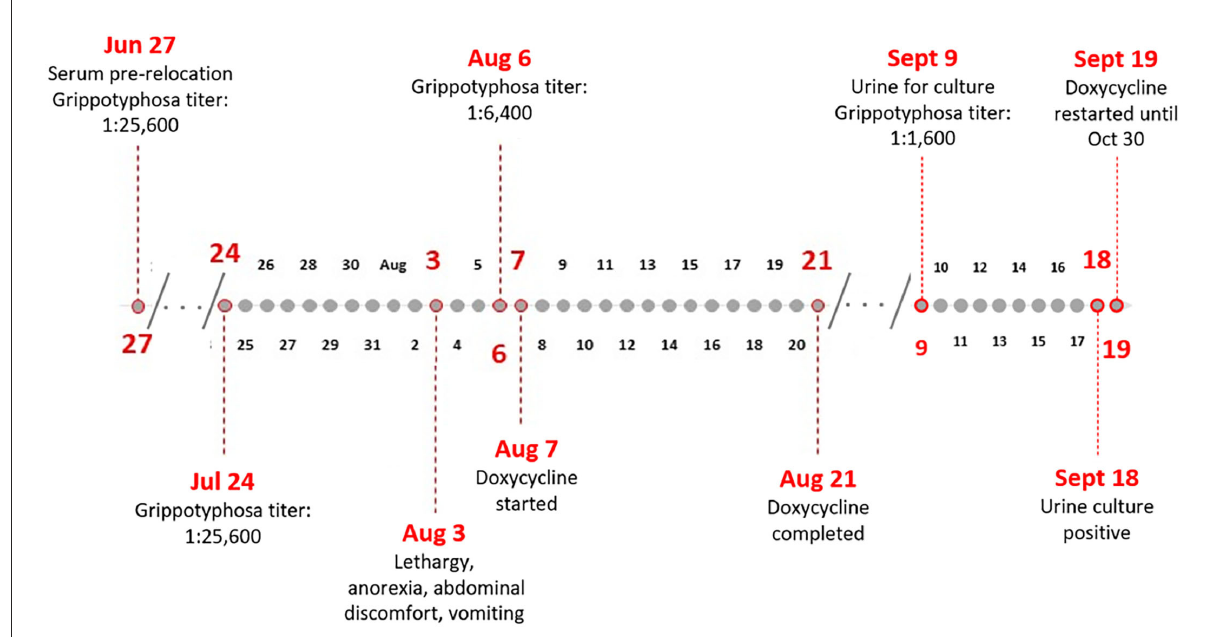
FIGURE1 Timeline of events illustrating the red panda symptoms, treatment, and testing